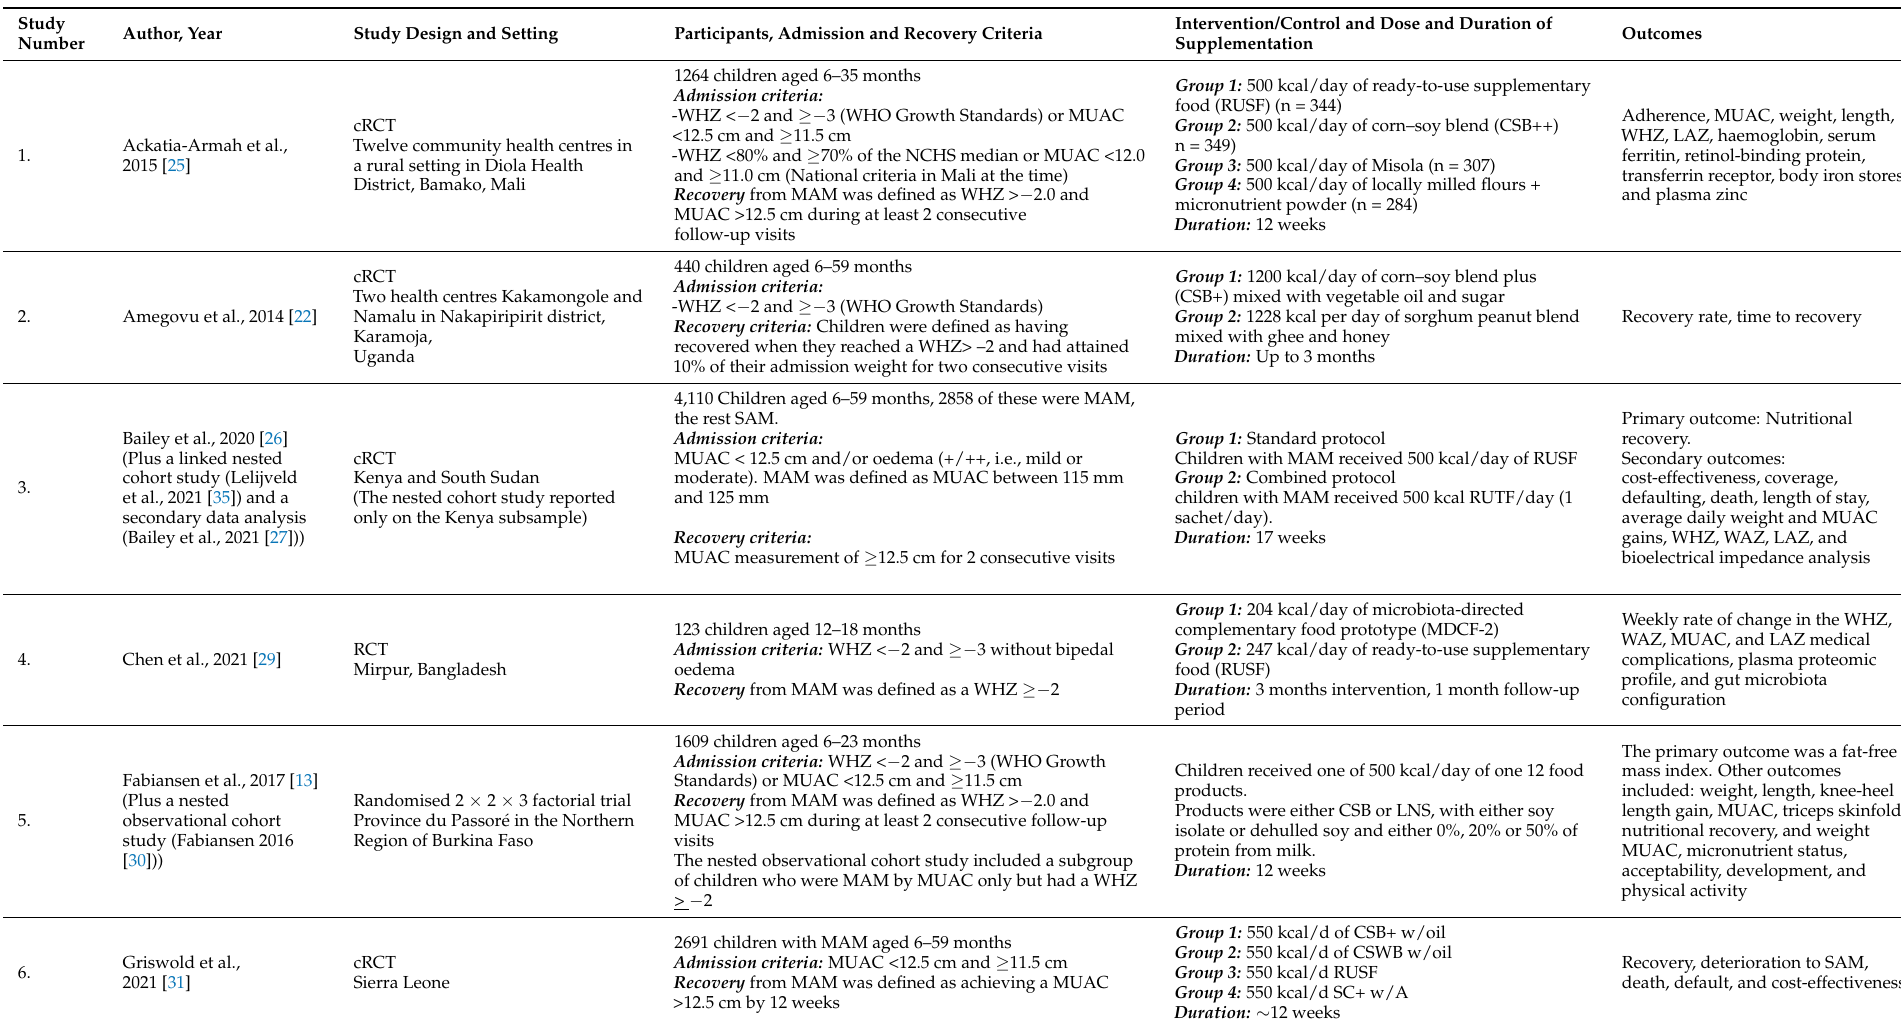
Table 2. Characteristics of the included studies 1